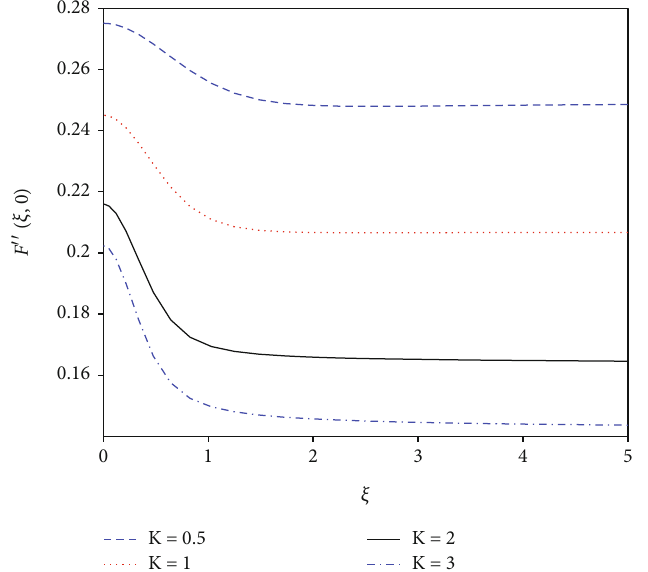
Figure 13: Development of the wall shear stress F ′′ ð ξ , 0 Þ for di ff erent values of vortex viscosity parameter K , when n = 0, ξ = 5, Pr = 10, and S = Ω = N = He = 0 : R